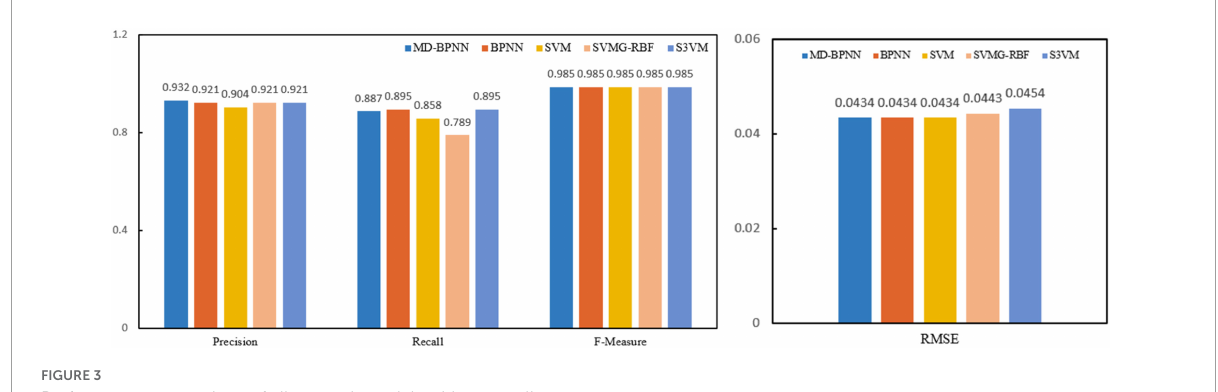
FIGURE3 Performance comparison of all network models with resampling.